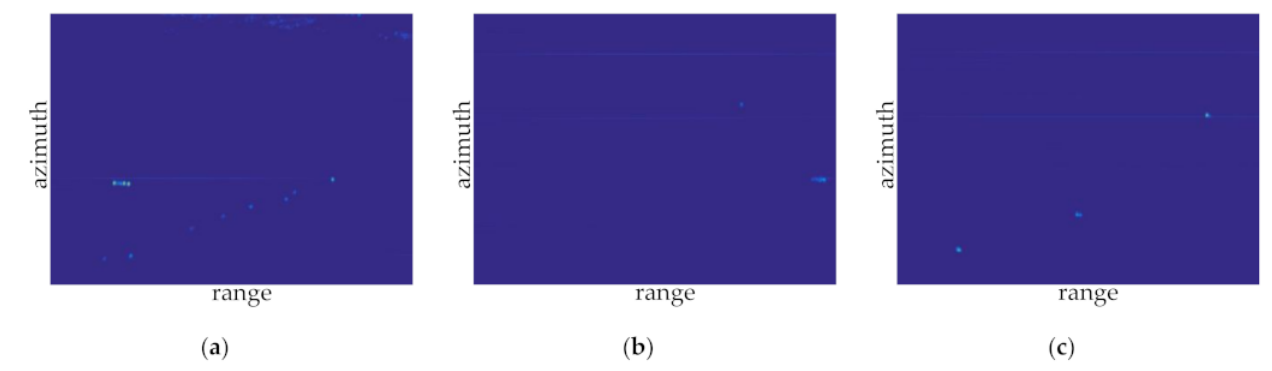
Figure 14. Image samples in distant water: ( a ) sample 4; ( b ) sample 5; and ( c ) sample 6.